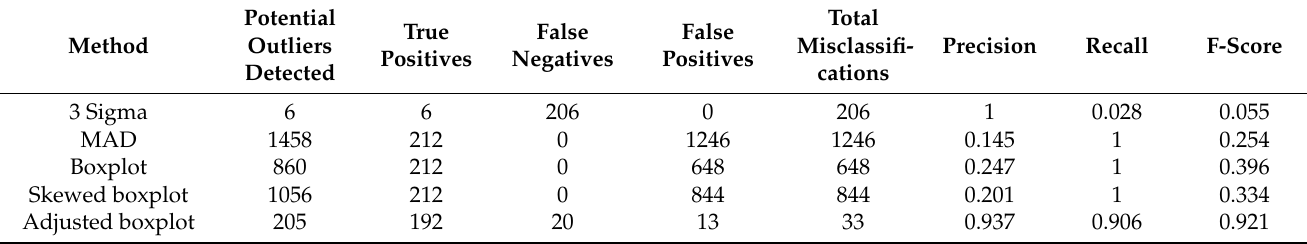
Table 8. Number of outliers found by the forecast error method applied to the random forest forecasts on the real data.